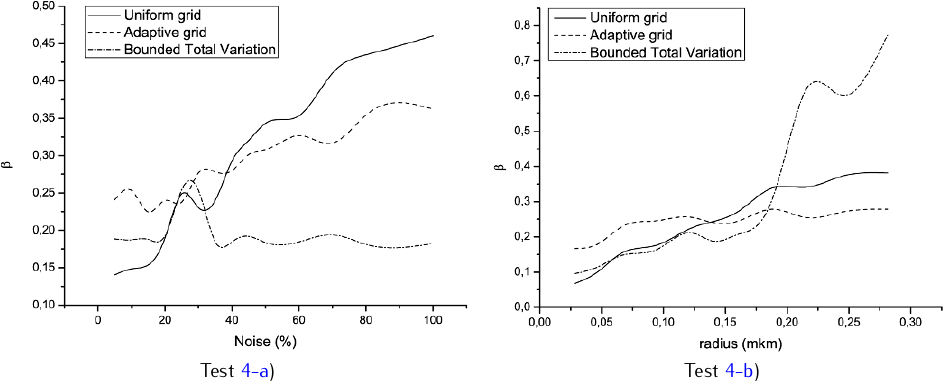
Figure 5. Test 4. Performance comparison of an adaptive finite element method, uniform grid deconvolution method and Bounded Total Variation